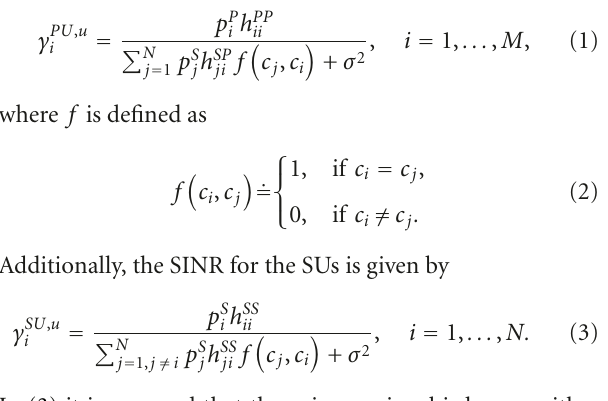
Figure 1: Cognitive system architecture.